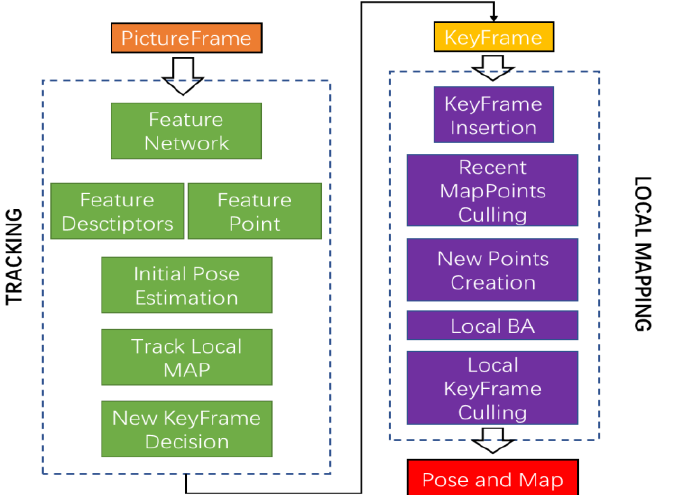
Figure 4. Overview of the Visual SLAM System. The proposed visual SLAM system mainly includes two modules, the tracking module, and the local mapping module.